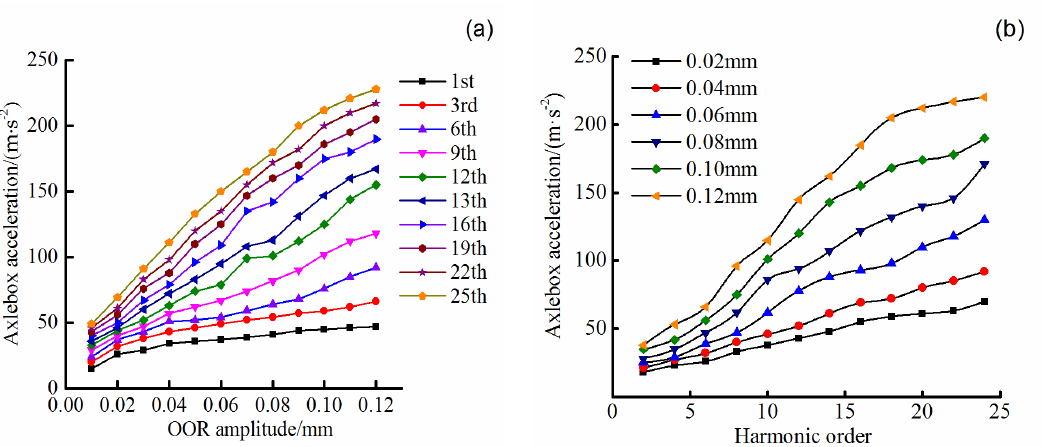
Figure 4. Vertical acceleration of axle-box as a function of ( a ) out-of-roundness (OOR) amplitude and ( b ) harmonic order of polygonized wheel at 350 km·h − 1 .